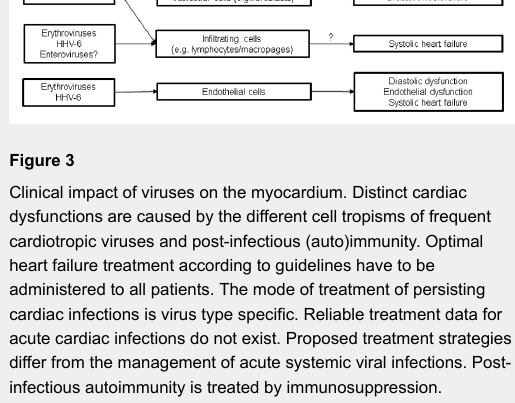
Table 2: Biopsy-based specific treatment options in patients with virus associated myocarditis. Clinical diagnosis Virus PCR